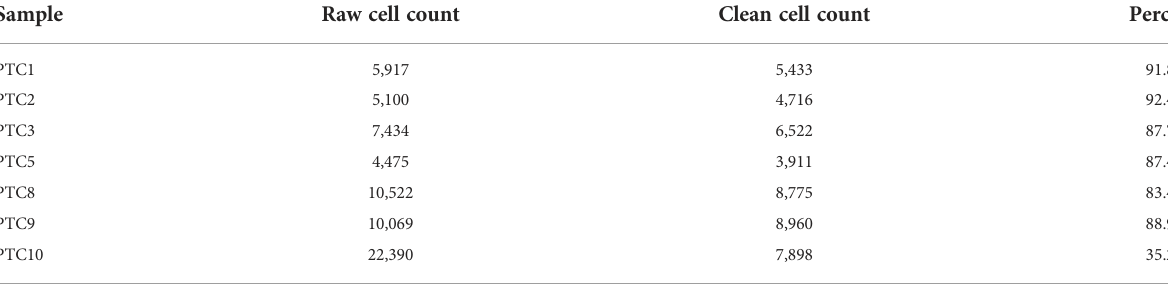
TABLE 2 Cell number statistics before and after sample quality control.